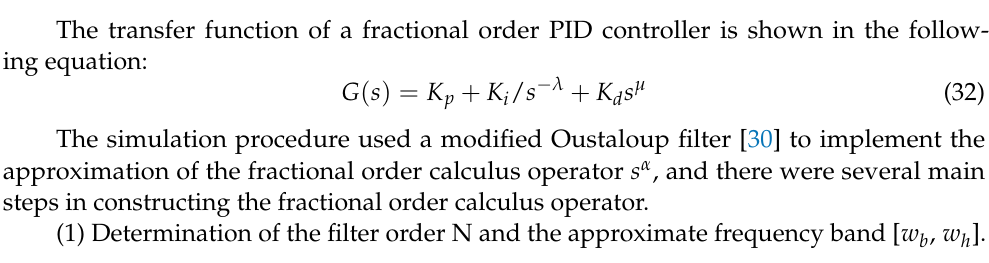
Figure 12. Block diagram of the suspension system control principle.